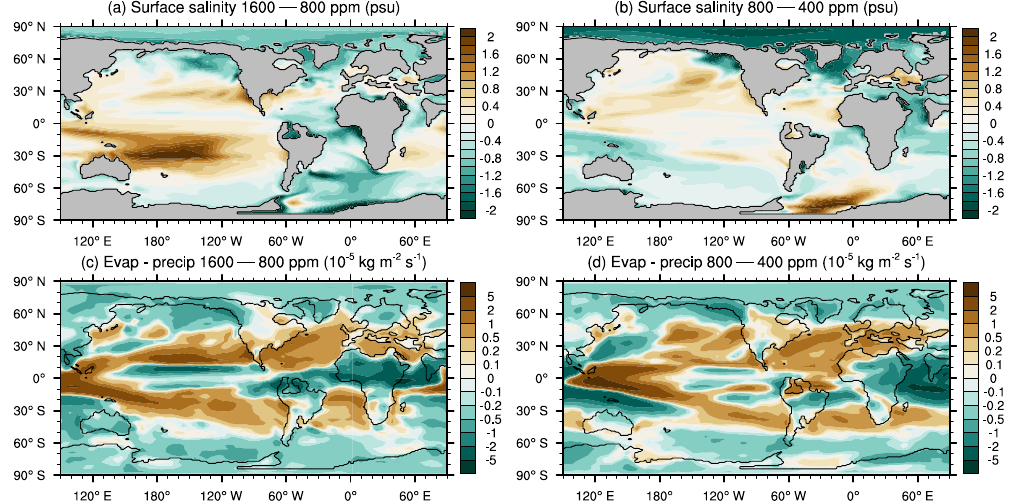
Figure 12. Surface salinity changes between (a) 1600–800ppm and (b) 800–400ppm, with the corresponding changes in evaporation minus precipitation for (c) 1600–800ppm and (d) 800–400ppm. Note the nonlinear scale in panels (c–d)